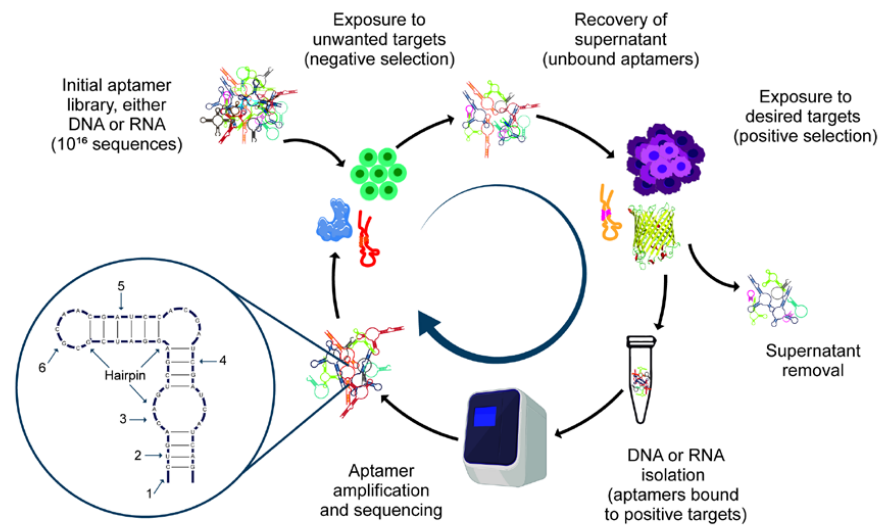
Figure 2. General scheme of the aptamer selection process and possible structural modifications. 1. The 5′ end PEGylation for resisting renal clearance. 2. Nucleobase modification for improving binding affinity and specificity. 3. Phosphodiester backbone modifications for resisting nuclease degradation. 4. Modifications on the sugar ring for resisting nuclease degradation. 5. The 3′ end - capping strategy resisting nuclease degradation. 6. The mirror image L-deoxyoligonucleotide resisting nuclease degradation. In the cell-SELEX process, green cells represent the non-desired cells used for the negative selection step and magenta cells represent the target cells required for the positive selection.